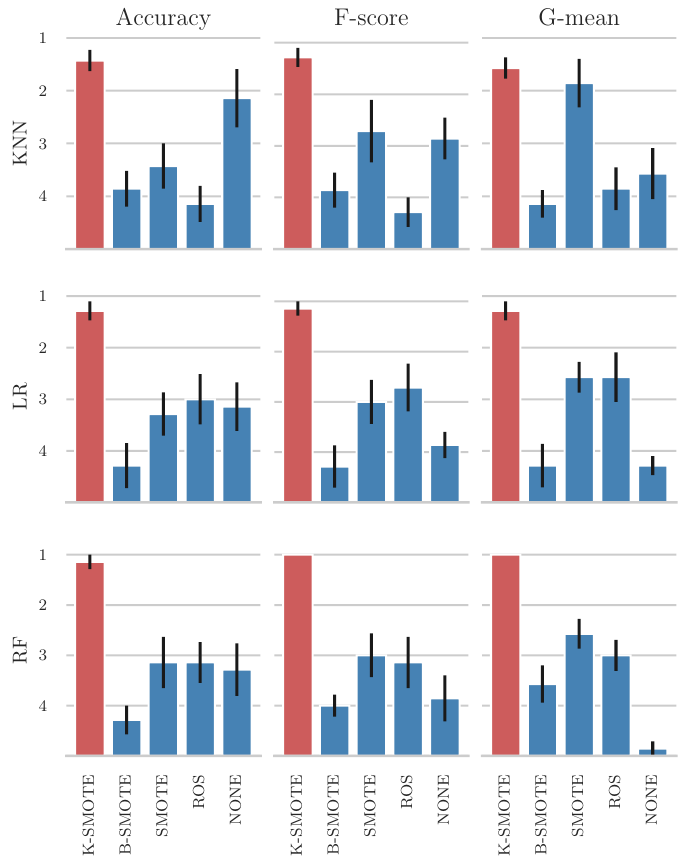
Figure 7. Results for mean ranking of oversamplers across